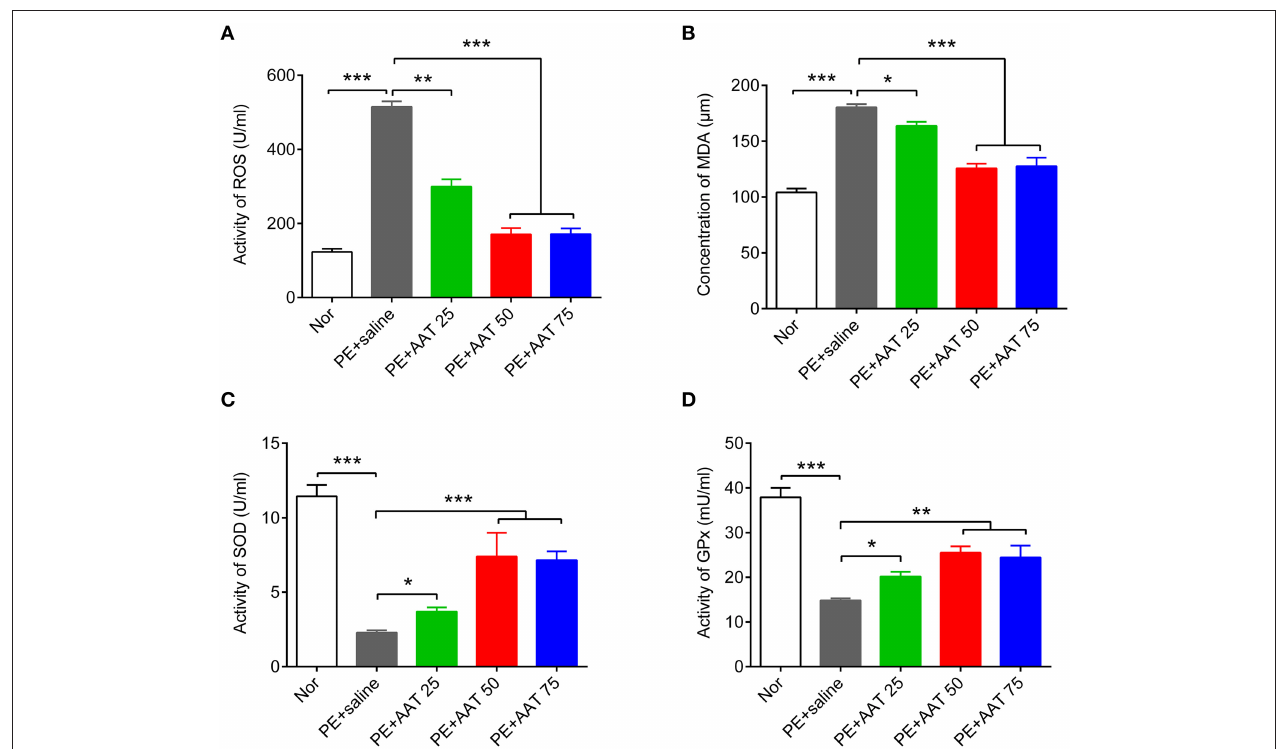
FIGURE 3 | AAT decreases the activity of ROS and the concentration of MDA, whereas increases the activity of SOD and GPx. ELISA was used to detect the actvity of ROS (A) , the concentration of MDA (B) , and the activity of SOD (C) , and GPx (D) in serum from all groups. N = 8 . * p < 0.05 , ** p < 0.01 , *** p < 0.001